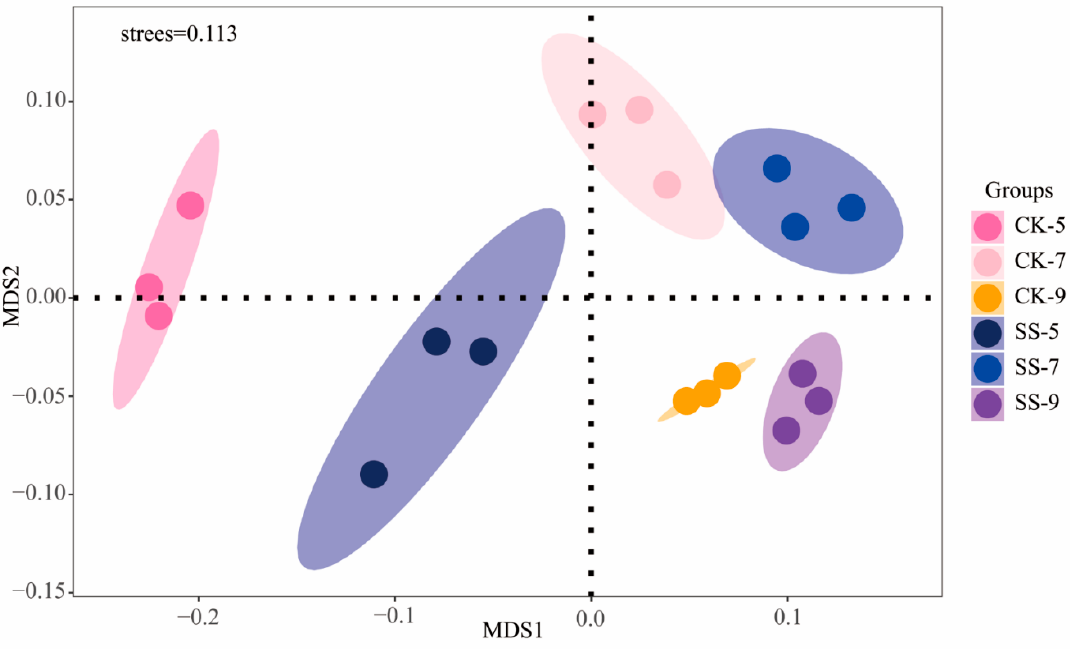
Figure 4. NMDS (non-metric multidimensional scaling) ordination based on Bray–Curtis similarities of bacteria communities in CK-5, CK-7, CK-9, SS-5, SS-7, SS-9 samples. CK: Control, soil of non-infected P. sylvestris var. mongolica ; SS: treatment, soil of infected P. sylvestris var. mongolica ; May, July, and September represent spring, summer, and autumn, respectively.